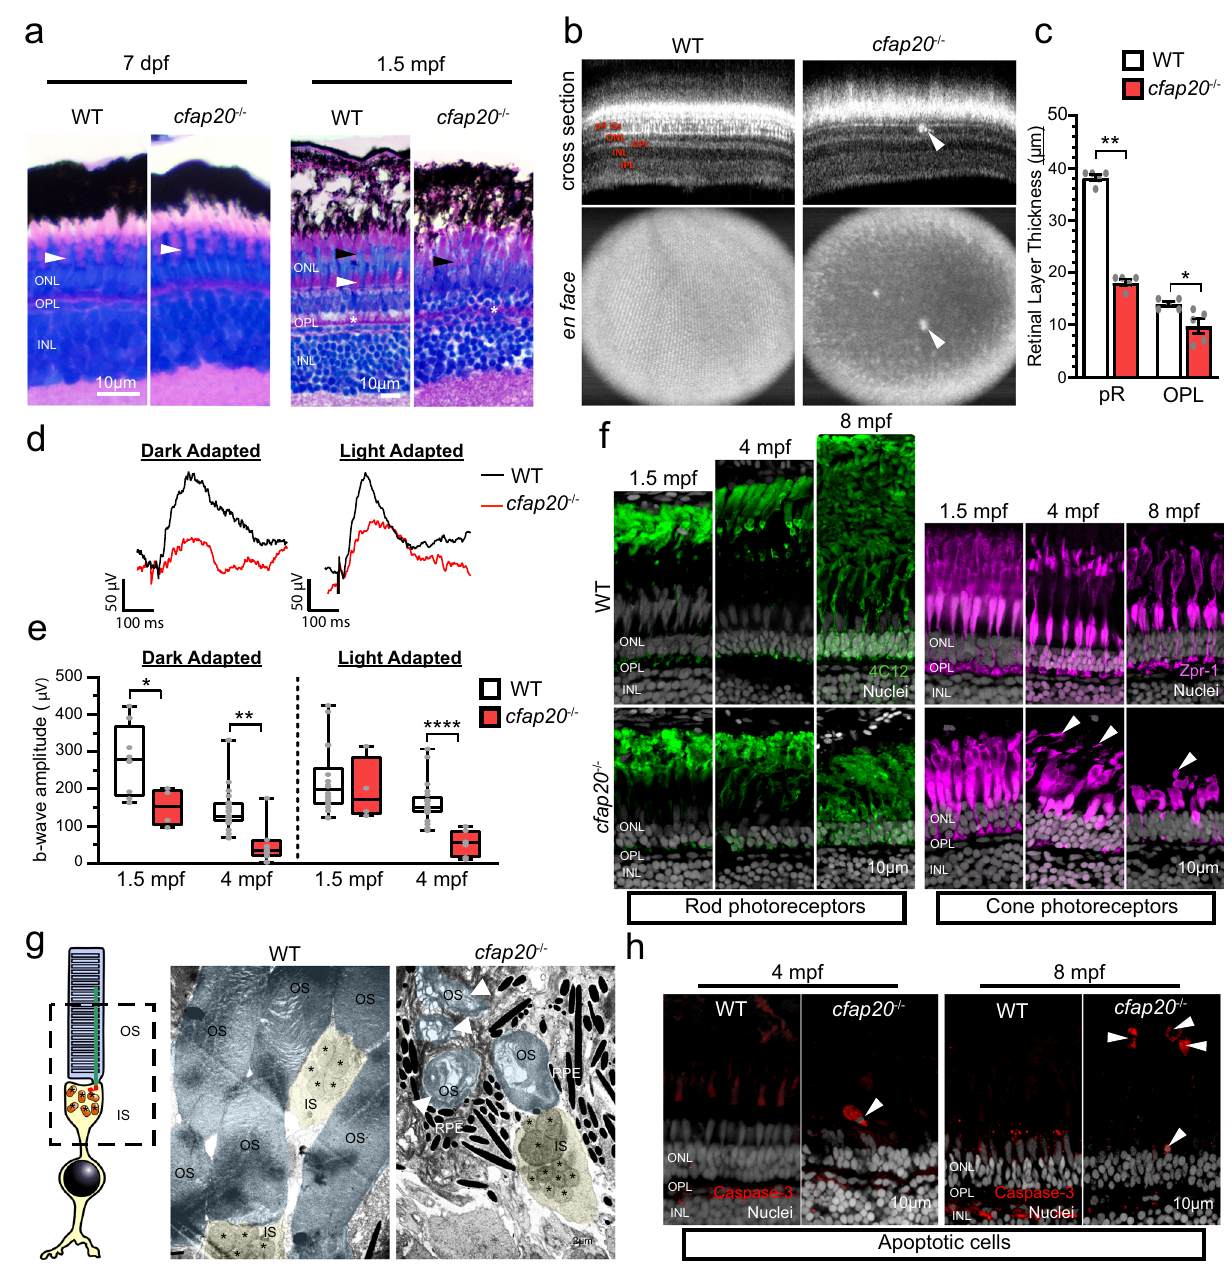
Fig. 7 | Zebra fi sh cfap20 − / − mutants model early-onset, progressive retinal dystrophy. a The larval, 7 days post-fertilisation, cfap20 − / − homozygote retina is indistinguishable fromwildtype (WT) animals (green bracket=rod and blue/red/ green cone OS and RPE, white arrowhead=UV cone OS). By 1.5 months post- fertilisation (mpf) the homozygote retina is degenerate with loss of organised conesubtypelayers(greenbracket=rodOSandRPE,whitearrowhead=UVcone OS, black arrowhead=blue/red/green cone OS) and poorly de fi ned OPL (aster- isk). b, c By 4 mpf, the cone mosaic is lost in homozygotes and hyperre fl ective blebs (arrows) are observed in the outer retina (Optical Coherent Tomography B-scans(cross section) and enface projections).ThephotoreceptorandOPLsare thinner in homozygotes ( n =5; error bars=SEM; two-tailed unpaired Mann- Whitney, pR P =0.0079, OPL P =0.0238). Representative full- fi eld electro- retinogram traces from 4 mpf dark (DA) or light adapted (LA) animals presented in d . e At both ages, the DA b-wave is reduced in homozygotes (two-tailed